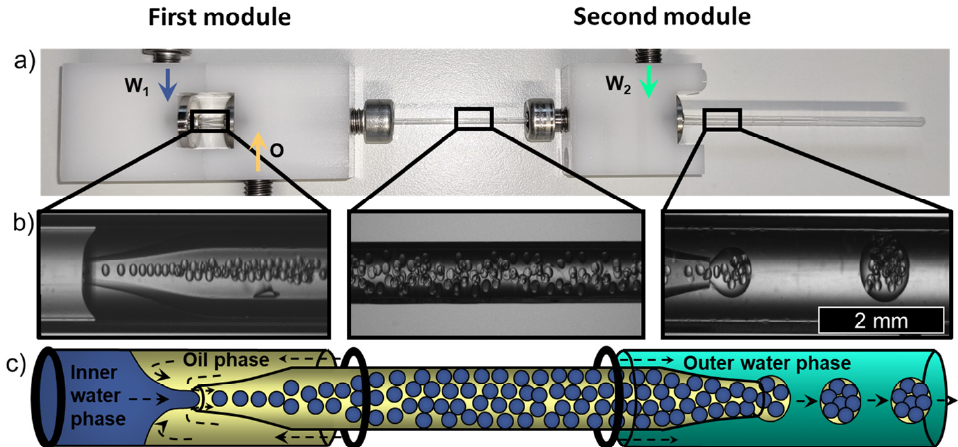
Figure 1. ( a ) Photography of the used combination of two microfluidic break up points. In the first module the inner emulsion is produced, in the second module is the double emulsion. ( b ) Microscopic images of the break-up points and the transport capillary between the devices. ( c ) A schematic drawing of the process. Reprinted from Leister et al. [45] with permission from Elsevier.